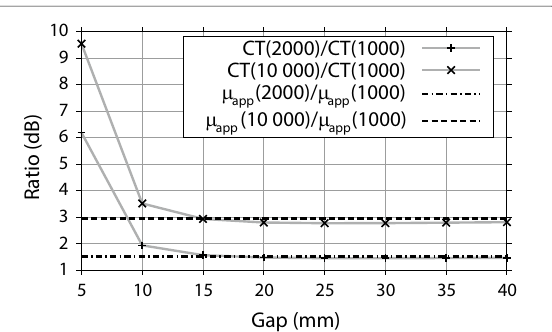
Fig. 10 Simulation results of crosstalk for the three-axis magnetic Fig. 11 Simulation results of ratio between each crosstalk. The dot- 200 mm, 10,000 , length cores. The laboratory measurements ( µ i ted and dashed-dotted lines show the ratio between each apparent = = 5 5 mm, and gap 18,25 , and 28 mm) are cross-sectional area magnetic = × = added for reference